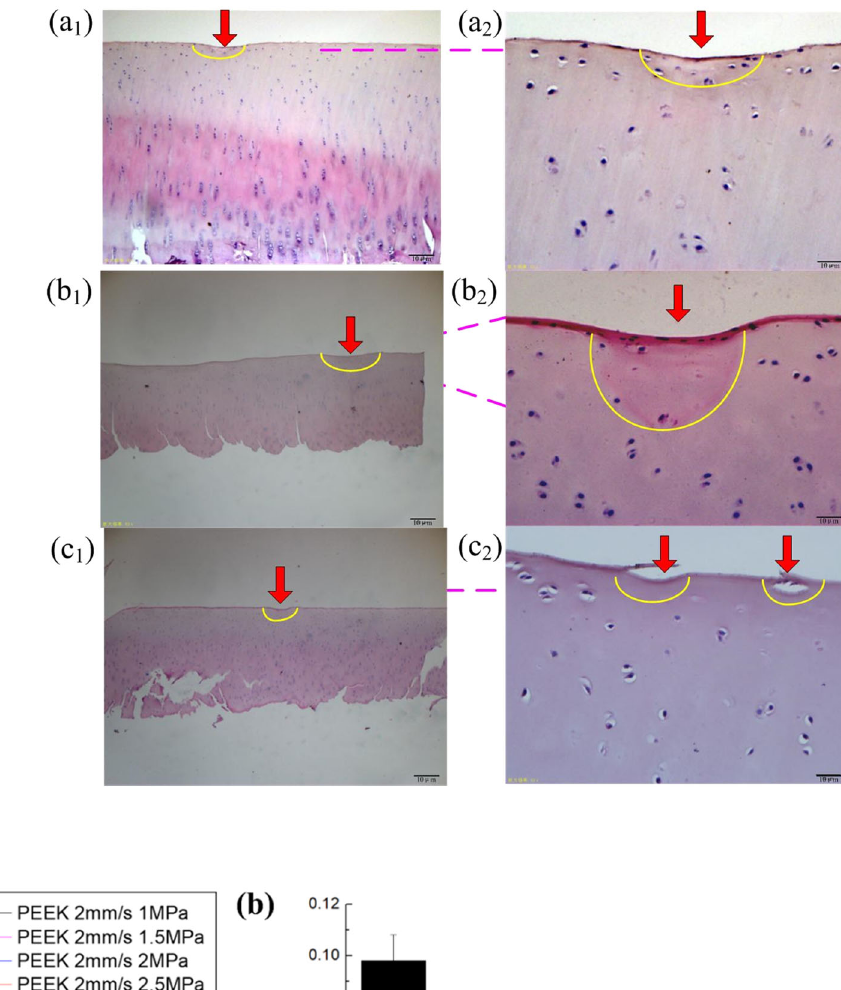
Fig. 9 HE staining of articular cartilage surface in different friction pairs. a1